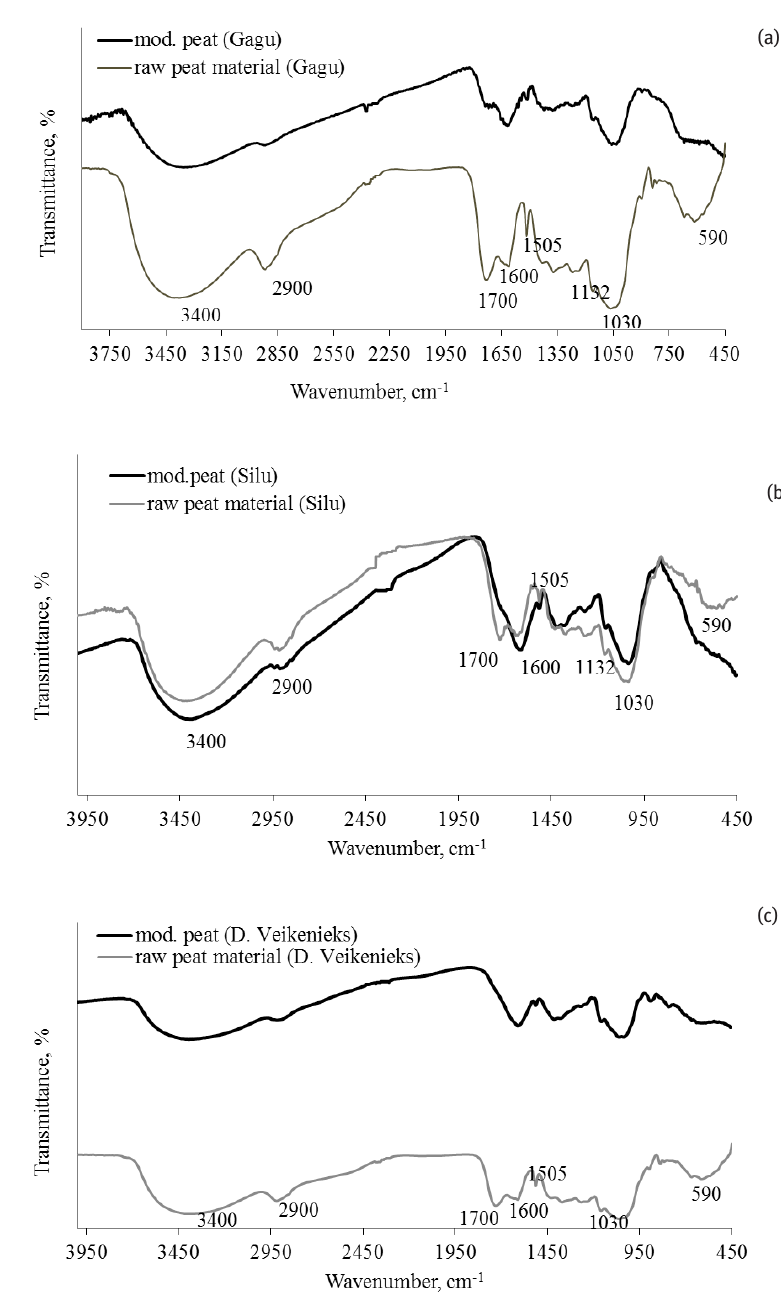
Figure 2: FT-IR spectra of Fe-modified peat and raw peat material – a) the Gagu Bog; b) the Silu Bog; c) the D. Veikenieks